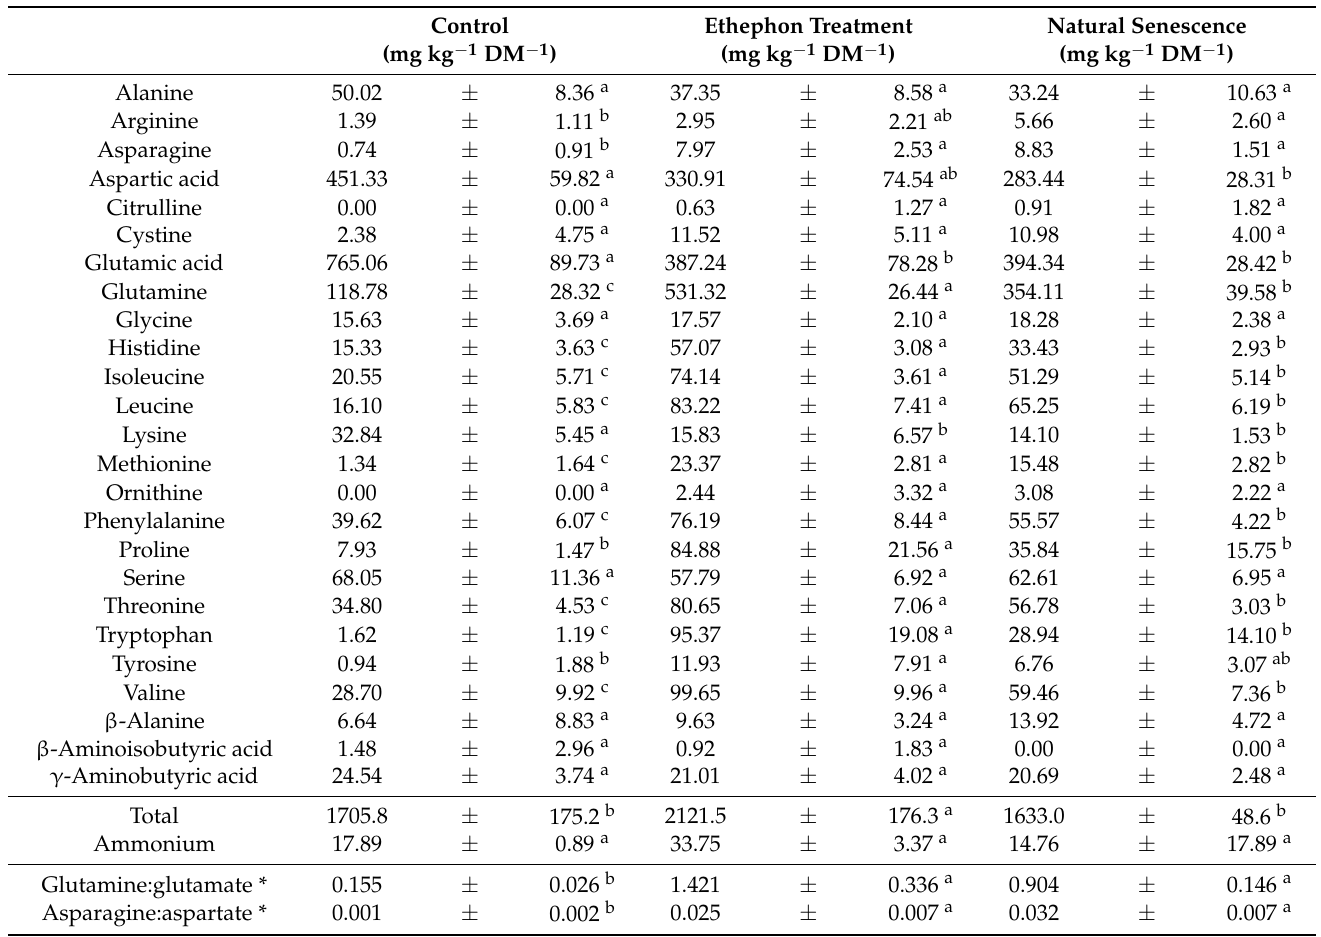
Table 3. Mean amino acid and ammonium concentrations, as well as the glutamine:glutamate and asparagine:aspartate ratio ± standard deviations, in leaves of control, ethephon-treated and naturally senescing Vitis vinifera cv. Riesling vines ( n =